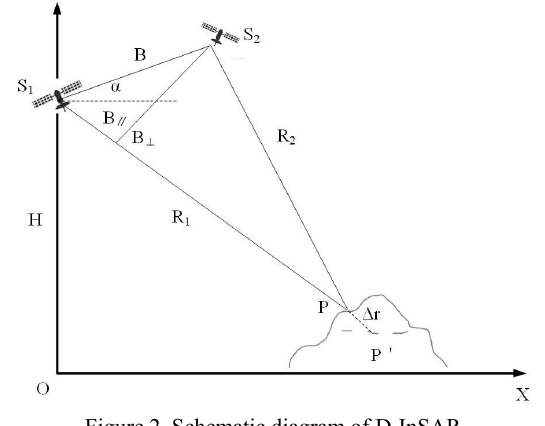
Figure 2. Schematic diagram of D-InSAR After removing topo